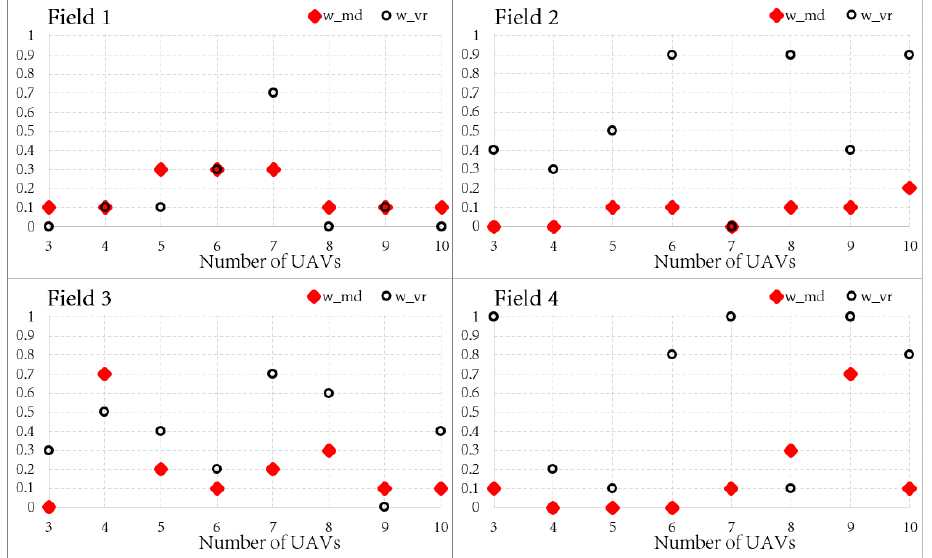
Figure 11. Weight parameters ( w md and w vr ) tuning to optimize the fleet moves needed to cover the 99% of the map (with CS = 30 m). The tuning is performed for all four maps shown in Figure